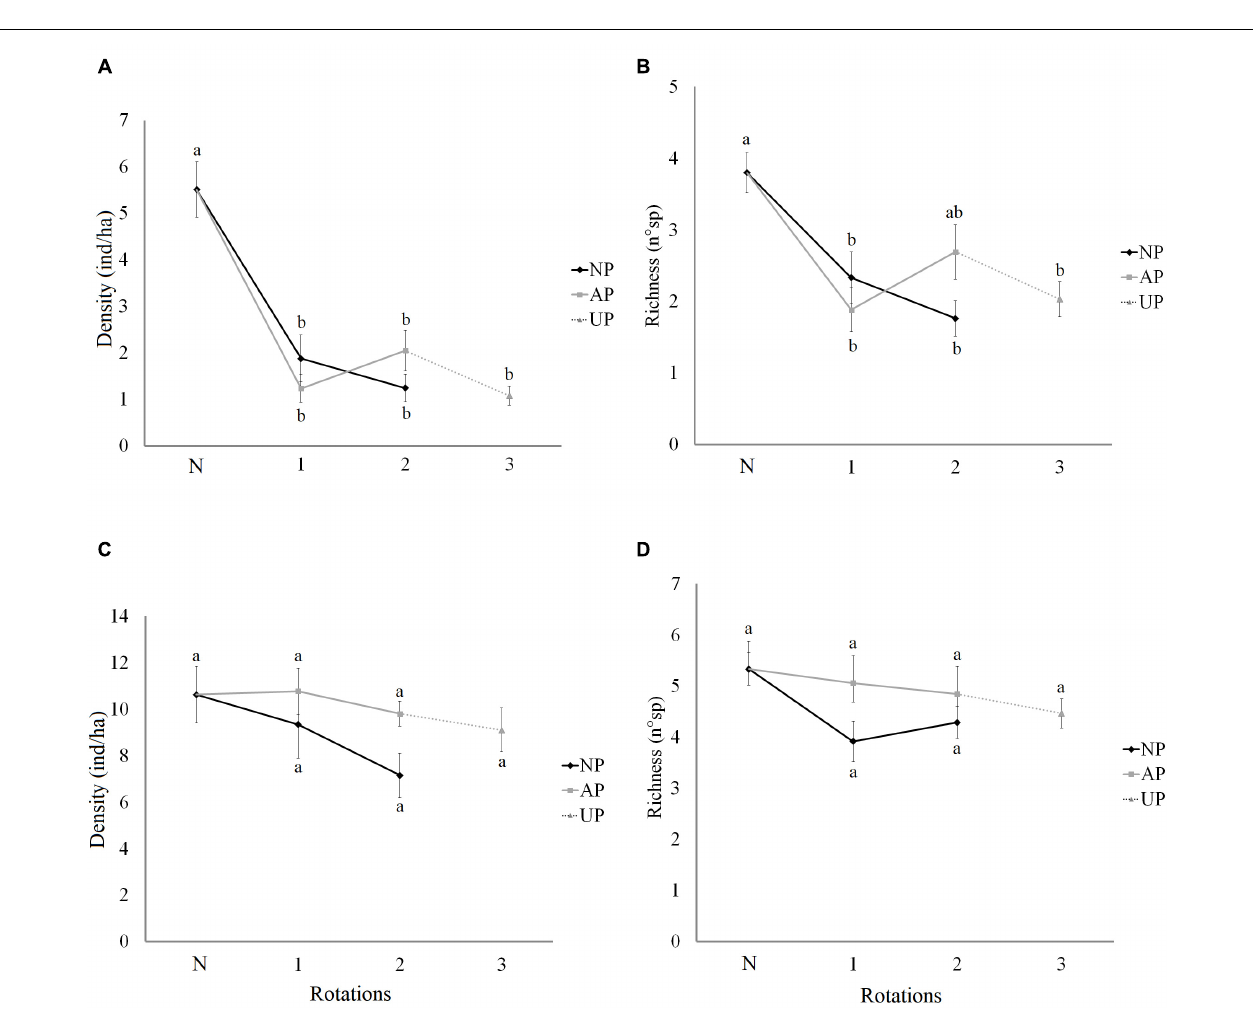
FIGURE 5 | Abundance and species richness of diurnal birds in native forests and pine plantations with different origin and number of rotations. (A) Abundance of forest-specialist birds. (B) Richness of Richness of forest-specialist birds. (C) Abundance of habitat-generalist birds. (D) Richness of habitat-generalist birds. N in x -axis is Native forest. NP, native forest transformed into pine plantation, AP, agricultural land transformed into pine plantation, UP, unknown previous land use (assumed as agricultural land) transformed into pine plantation. Lower case letters indicate the significance of differences among categories obtained by BH multiple